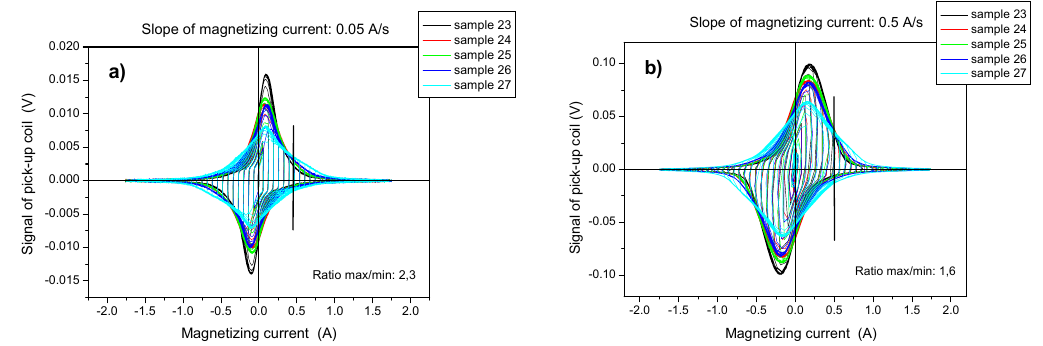
Figure 5. Series of minor permeability loops measured by MAT on the investigated samples. ( a ) with 0.05 A/s slope of magnetizing current, and ( b ) with 0.5 A/s slope of magnetizing current.